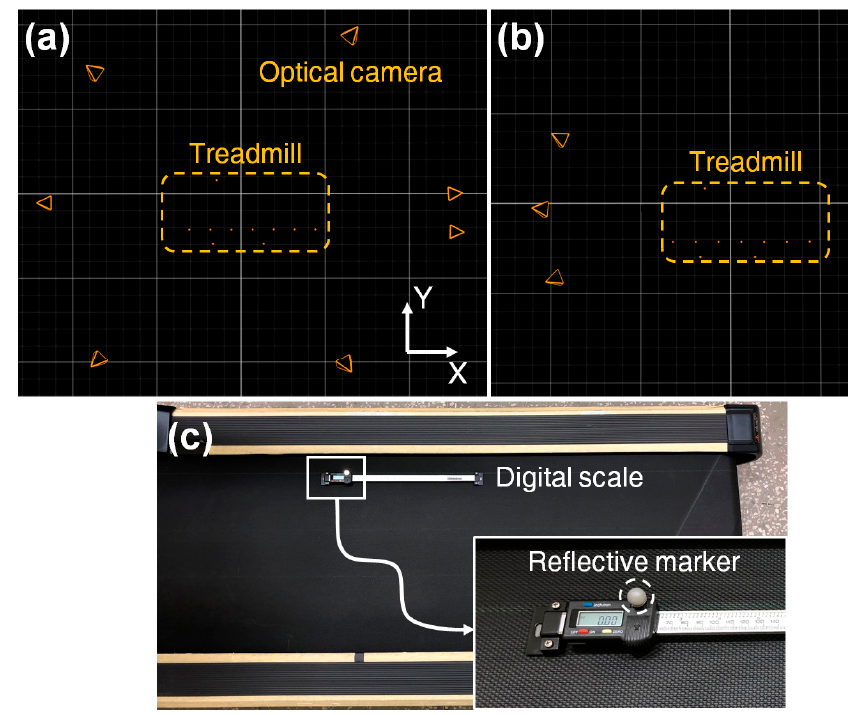
Figure 4. Setup for treadmill test without pedestrian walking: ( a ) camera setting 1, ( b ) camera setting 2, and ( c ) setup for evaluation using a digital linear scale.